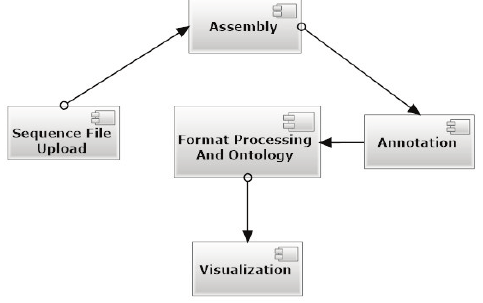
Figure 5: Linked Processes for the GITIRBio